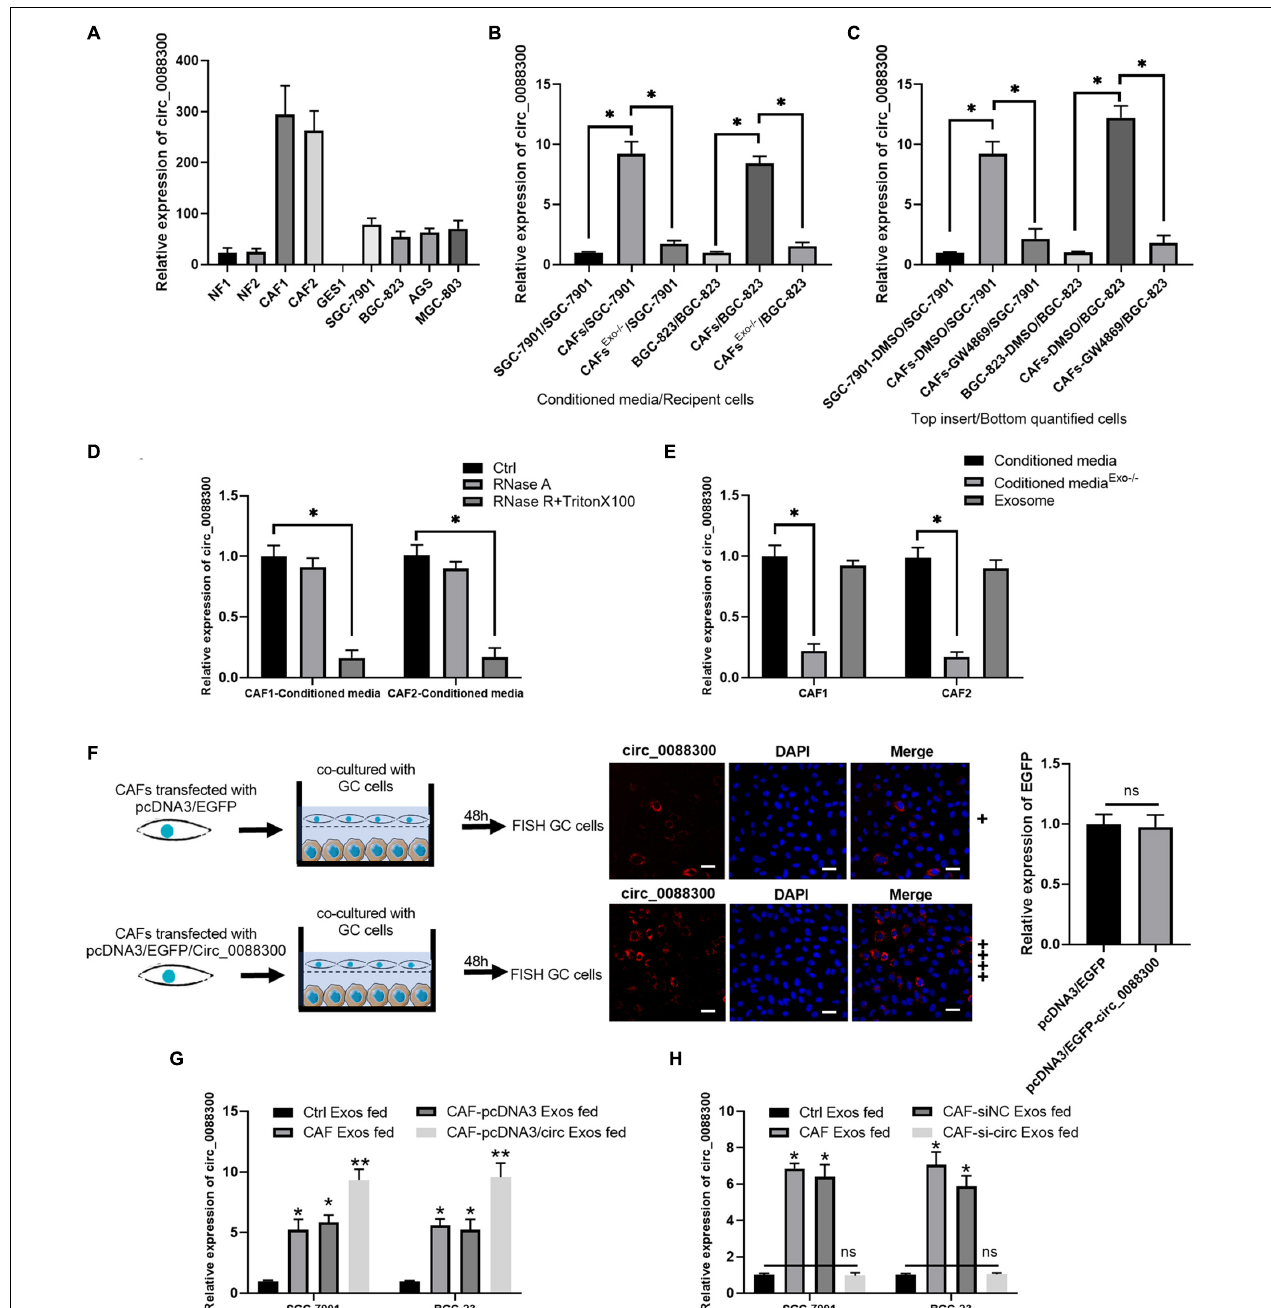
FIGURE 2 | CAFs in the tumor microenvironment might increase circ_0088300 expression levels in GC cells through direct circ_0088300 transfer. (A) circ_0088300 expression in NFs, CAFs, normal stomach epithelial cells (GES1), and GC cell lines (SGC-7901, BGC-823, AGS, and MGC-803) was analyzed via qRT- PCR. (B) SGC-7901 and BGC-823 cells were incubated with control conditioned media (CM), CAF-CM, or exosome-depleted CAF-CM for 24 h, and the circ_0088300 expression level in these cells was detected by qRT-PCR. (C) SGC-7901 and BGC-823 cells were co-cultured with DMSO-treated SGC-7901 and BGC-823 cells, DMSO-treated CAFs, or GW4869-treated CAFs for 24 h. The circ_0088300 expression level was detected in GC cells by qRT-PCR. (D) qRT-PCR of circ_0088300 expression in CAF-CM treated with RNase A (2 mg/mL) independently or cotreated with Triton X-100 (0.1%) for 20 min. (E) qRT-PCR of circ_0088300 expression in exosomes, exosome-depleted CM, and whole CM derived from CAFs. (F) CAFs transfected with pcDNA3/EGFP/circ_0088300 were cocultured with GC cells for 48 h. Fluorescence microscopy was used to detect red fluorescent signals in GC cells (scale bar = 50 µ m), and the expression of EGFP between two groups was not statistically different. (G) circ_0088300 expression in SGC-7901 and BGC-823 cells was detected by qRT-PCR at 24 h after incubation with exosomes (25 µ g/mL) derived from GC cells (Ctrl Exos), CAFs, or CAFs transfected with or without circ_0088300 mimics. (H) circ_0088300 expression in SGC-7901 and BGC-823 cells was detected by qRT-PCR at 24 h after incubation with exosomes (25 µ g/mL) derived from GC cells (Ctrl Exos), CAFs, or CAFs transfected with or without circ_0088300 siRNA (ns, no significant difference; * P < 0.05; ** P < 0.01).